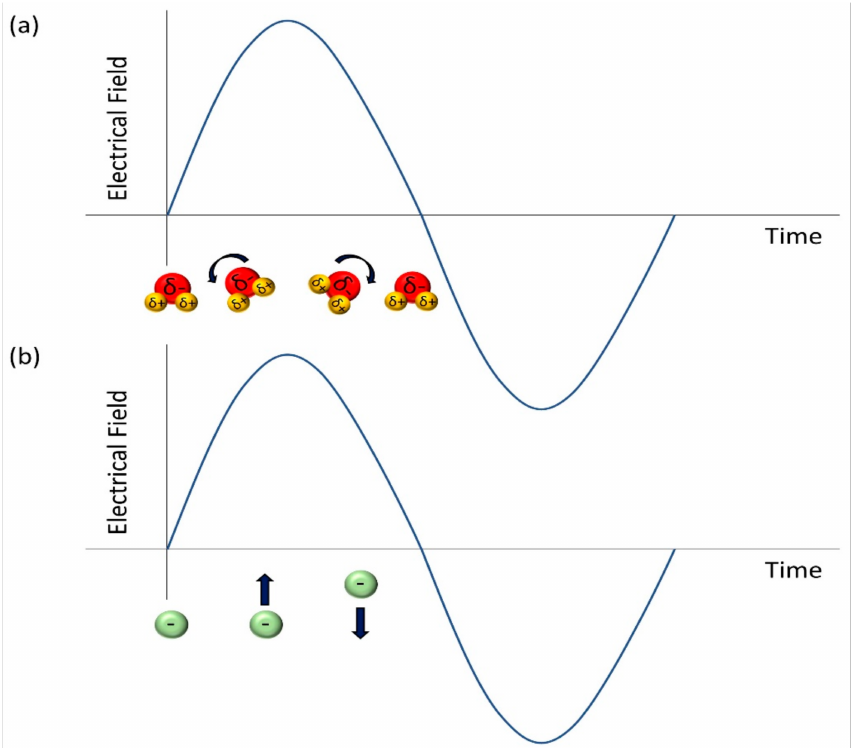
Figure 1. Electric field heating mechanisms under microwave. ( a ) Dipolar polarization which involves the rotation of polar molecule to align itself with electric field. ( b ) Ionic conduction that shows an ion moving back and forth if the molecule is